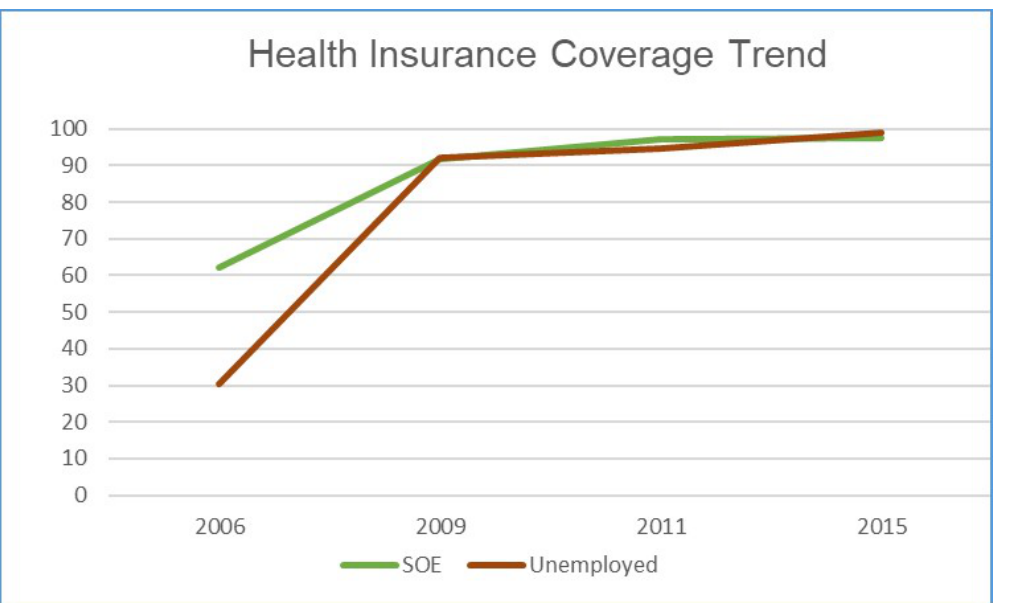
Figure 1. Health insurance usage by type and wave.